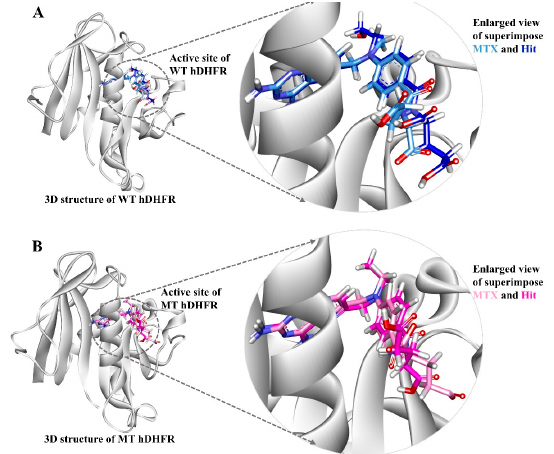
Figure 5. The binding patterns of the reference inhibitor (MTX) and hit compound in the active site of wild type and mutant hDHFR. Compounds are displayed by their representative structures superimposed (left) and enlarged (right). The protein is shown in white color. ( A ) Light blue and dark blue colors represent MTX and Hit compound in wild type hDHFR. ( B ) Pink and magenta colors represent MTX and Hit compound respectively in mutant hDHFR.